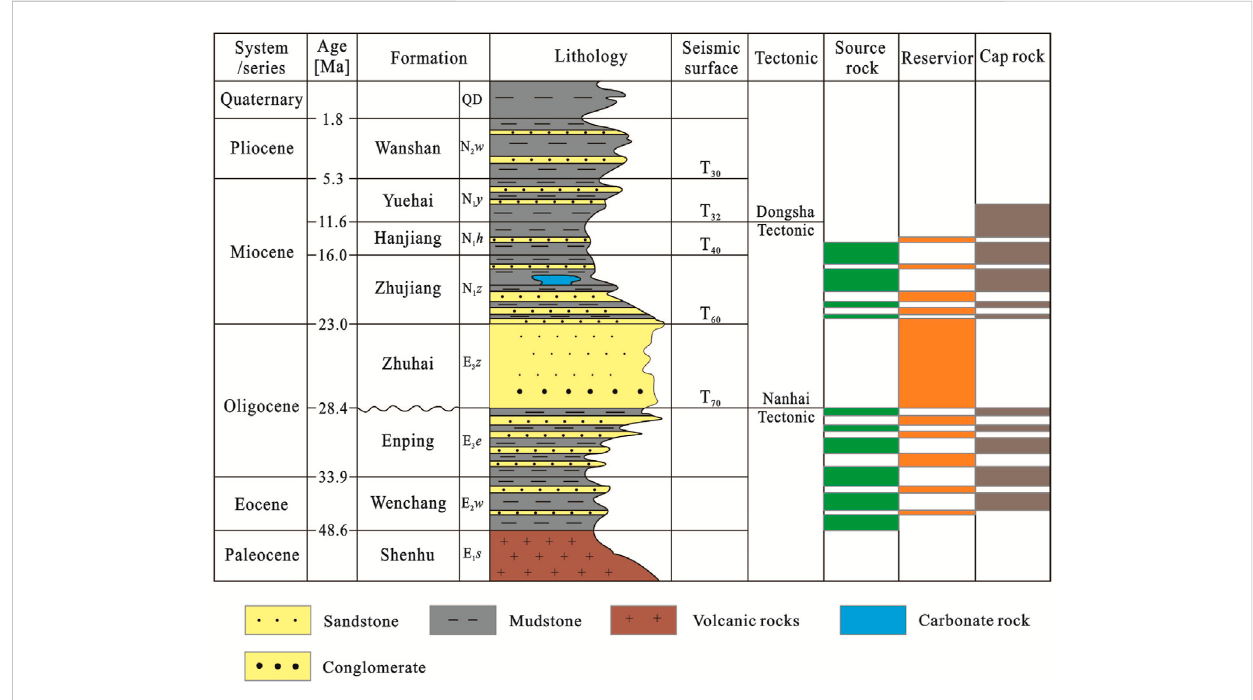
FIGURE 2 Stratigraphic column for the Baiyun